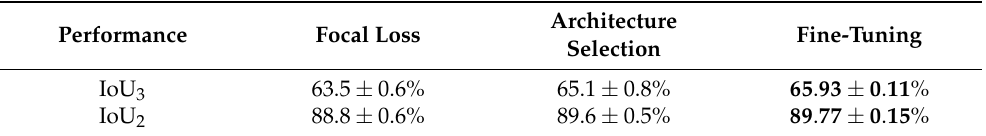
Table 3. Model performance depends on the